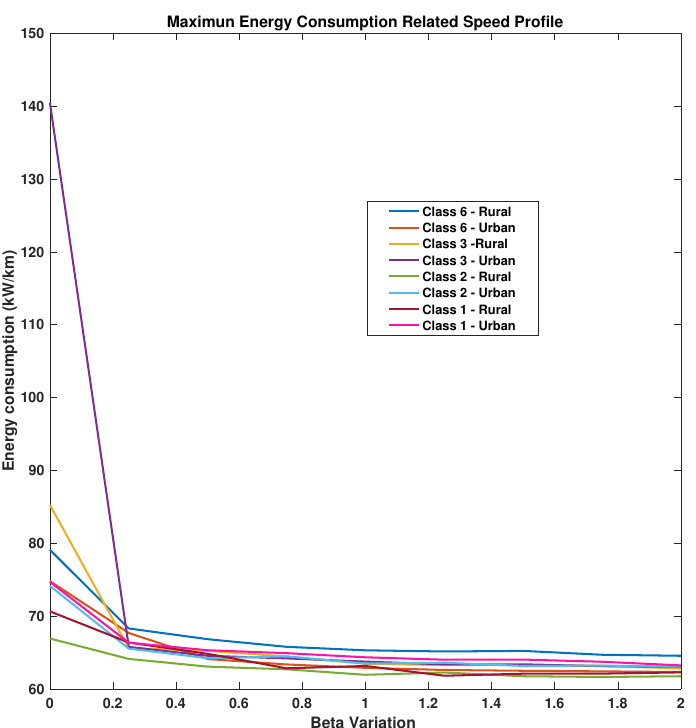
Figure 23. Energy coefficient along each speed profile.